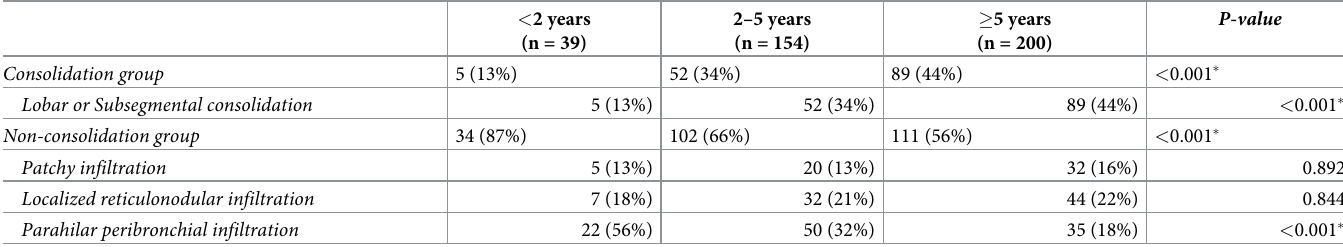
Table 3. Chest radiograph findings of children with Mycoplasma pneumoniae pneumonia by